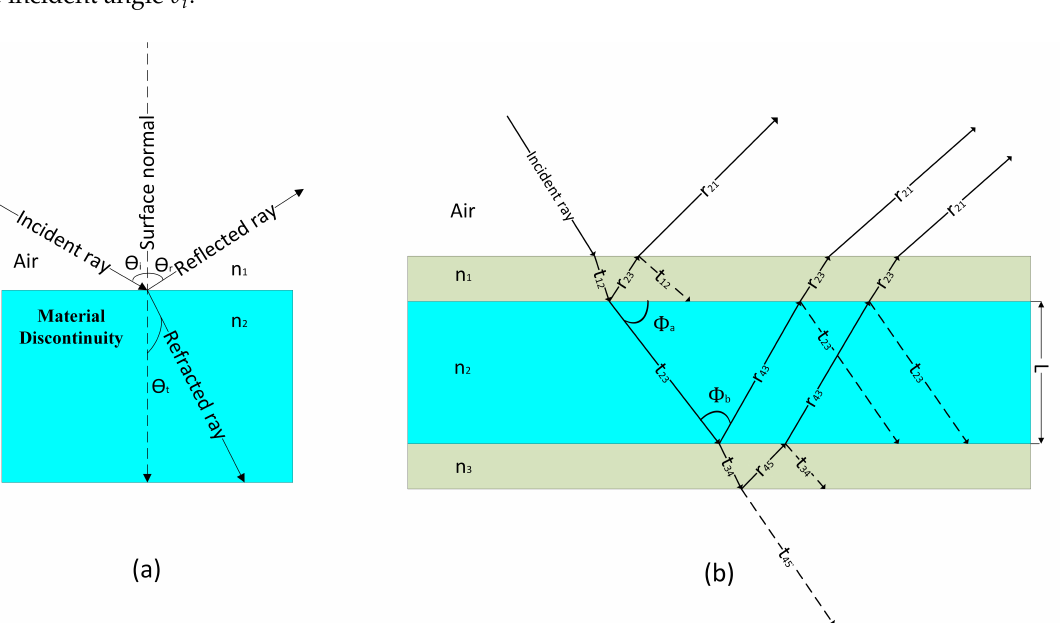
Figure 1. Vector diagram for transmission and reflection in FP-cavity when light comes across ( a ) Single and ( b ) Multiple material